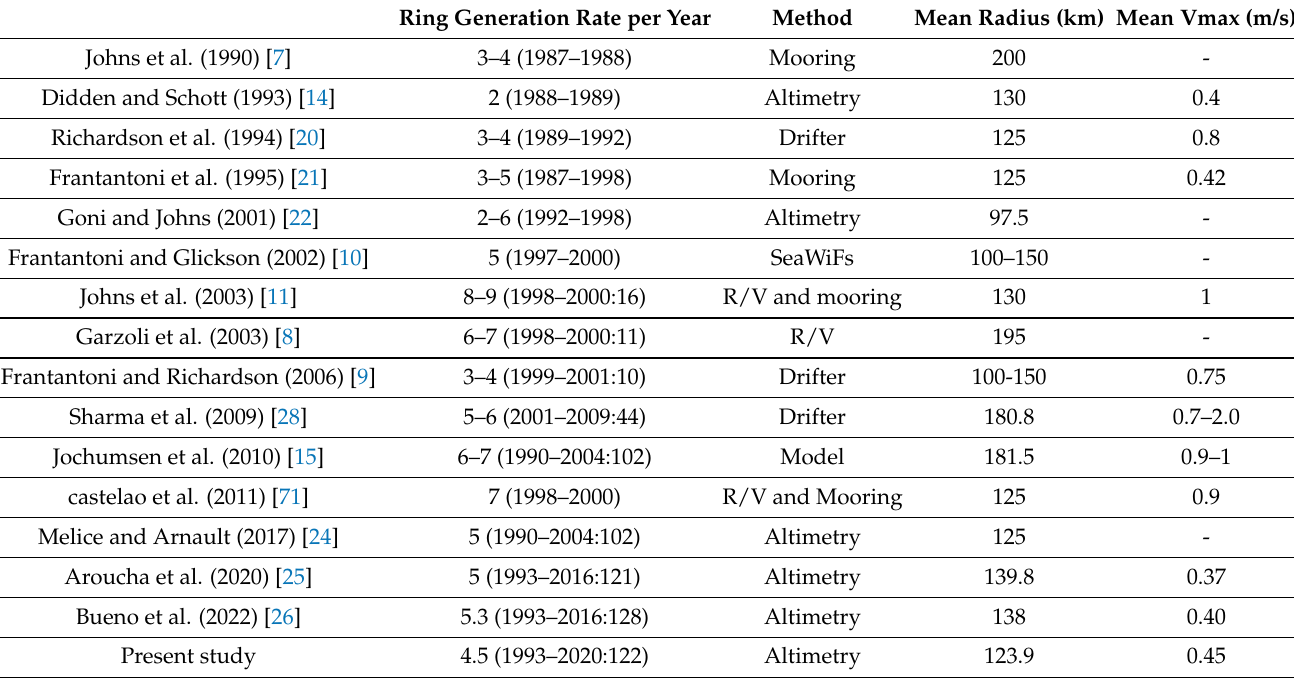
Table 3. NBC ring generation rates and properties from previous